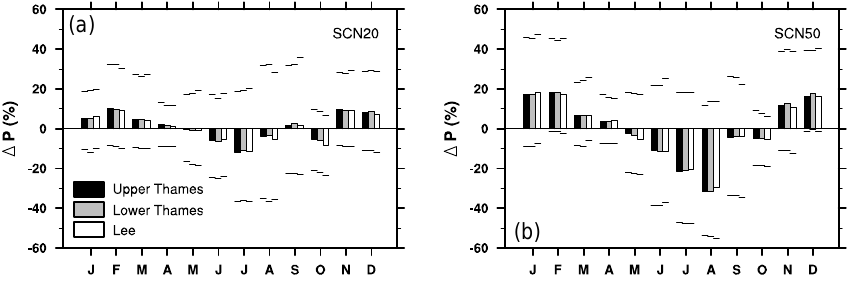
Figure 5. Percentage change in precipitation for (a) SCN20 and (b) SCN50. The bars denote the median change from the 100-member ensemble; the upper and lower horizontal lines indicate the ensemble 90th and 10th monthly percentiles,